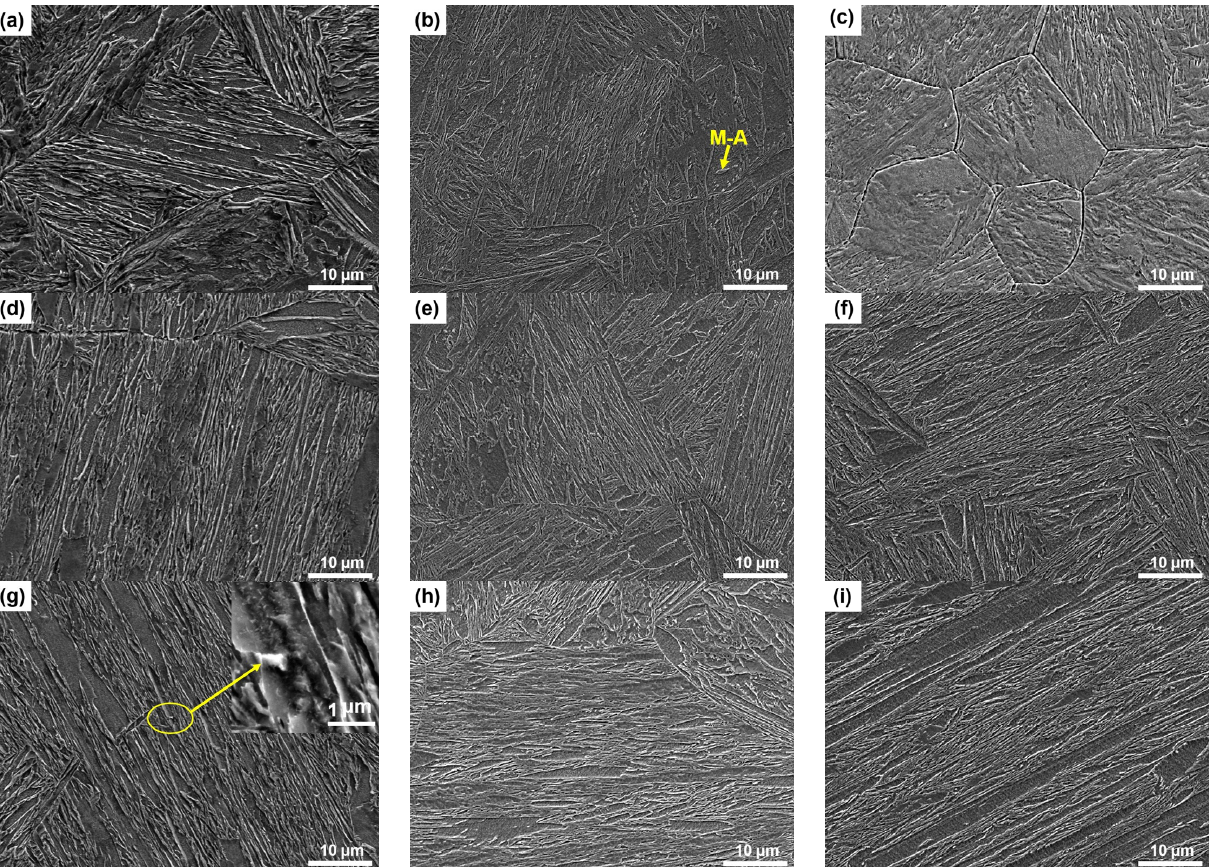
Figure 11. Microscopic structure at different peak temperatures and t 8/5 time: ( a ) 1200 °C, t 8/5 = 20 s, ( b ) 1200 °C, t 8/5 = 50 s, ( c ) 1200 °C, t 8/5 = 100 s, ( d ) 1250 °C, t 8/5 = 20 s, ( e ) 1250 °C, t 8/5 = 50 s, ( f ) 1250 °C, t 8/5 = 100 s, ( g ) 1300 °C, t 8/5 = 20 s, ( h ) 1300 °C, t 8/5 = 50 s, ( i ) 1300 °C, t 8/5 = 100 s.